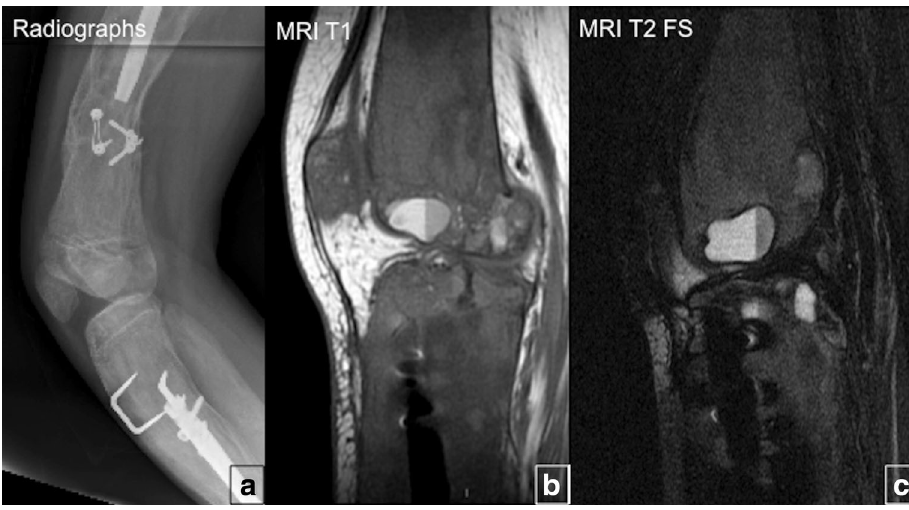
Fig. 16 Benign fibrous dysplasia (FD) bone matrix transformation toaneurysmal bone cysts (ABCs). a Radiographs of the distal femur and the proximal fibula show heterogeneous FD lesions with surgical hardware. T1-weighted MRI ( b ) and T2 fat-suppressed images MRI ( c )